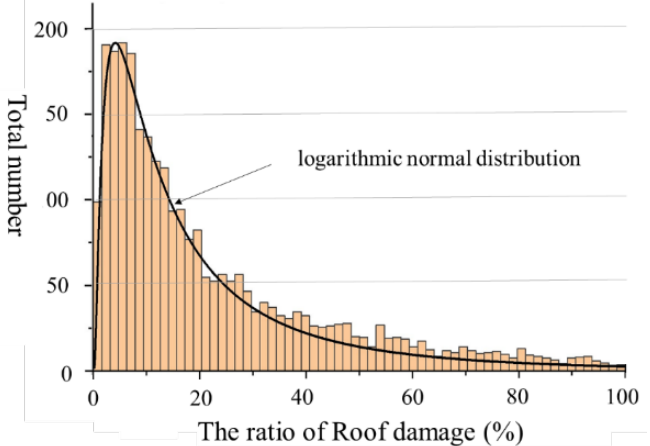
Figure 13. Statistics of detected roof damage.